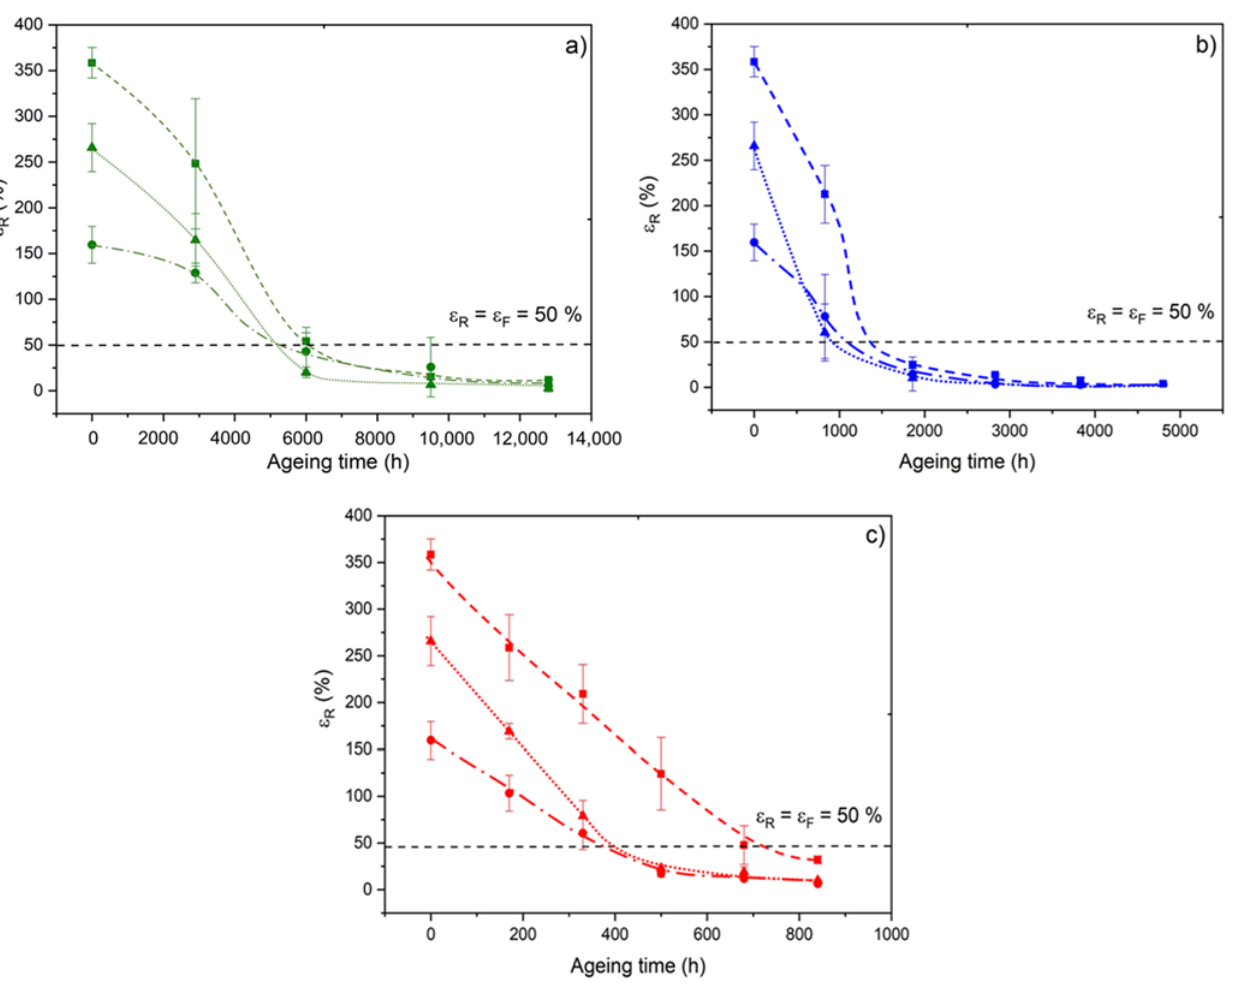
Figure 16. Changes in the elongation at break of the unfilled Si ‐ XLPE matrix ( □ ) and the two composite materials with 25 phr ( ∆ ) and 50 phr ( ) of ATH, during their radio-thermal exposure in air under 8.5 Gy ∙ h − 1 at 47 °C ( a ), under 77.8 Gy ∙ h − 1 at 47 °C ( b ), and under 400 Gy ∙ h − 1 at 21 °C ( c ). The horizontal dotted line corresponds to the end ‐ of ‐ life criterion. Table 5. Lifetime values (expressed in hours) graphically determined for the three materials under the three exposure conditions under study, as shown in Figure 16.